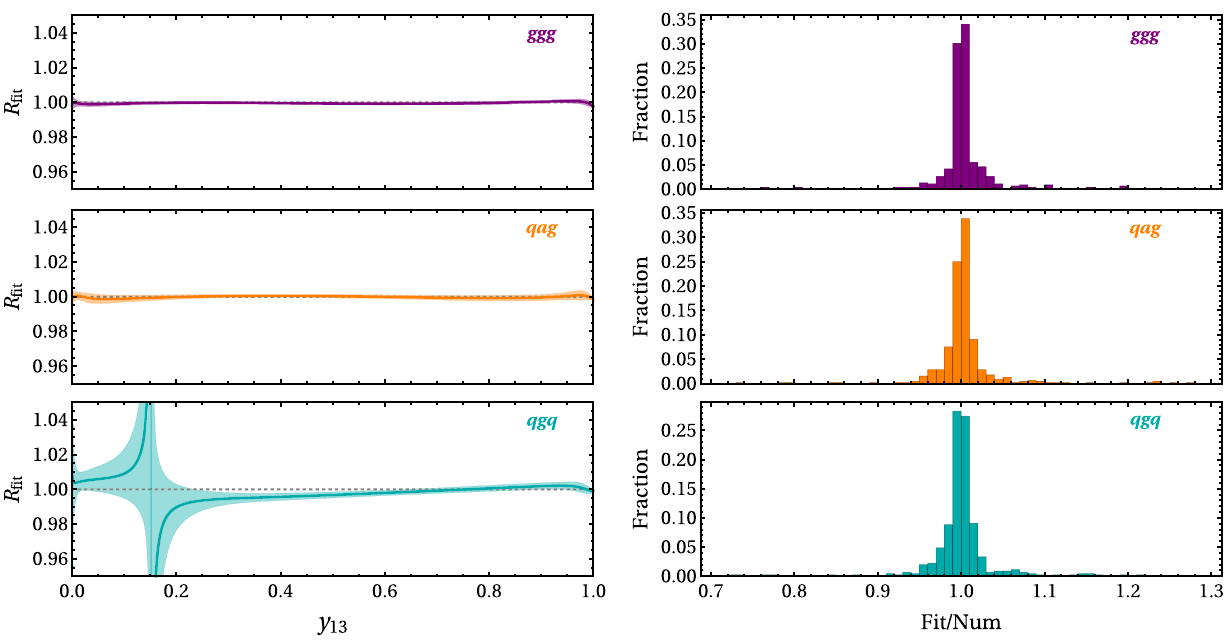
Fig. 6 The NLO and NNLO contributions to the soft function, shown for a notional value of α s /( 2 π) = 0 . 05